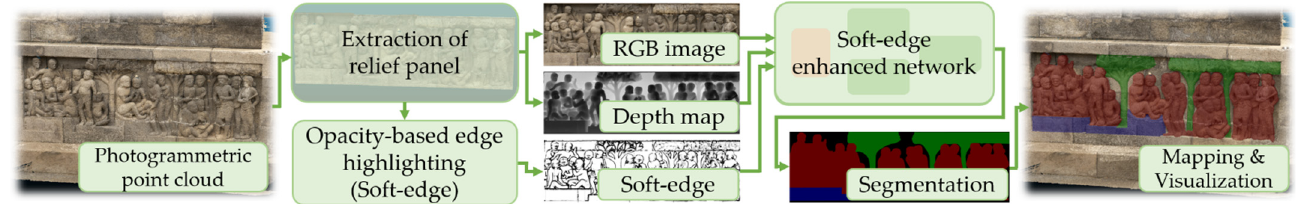
Figure 3. Block diagram: The first step is to extract the relief panel from the input and project the RGB image and depth map. Then, the soft edge is extracted by opacity-based edge highlighting. These images are transmitted to the soft-edge enhanced network as a multichannel to predict the two-dimensional semantic segmentation labels. Finally, the results are obtained by mapping the extracted semantic labels onto three-dimensional points of the relief data.